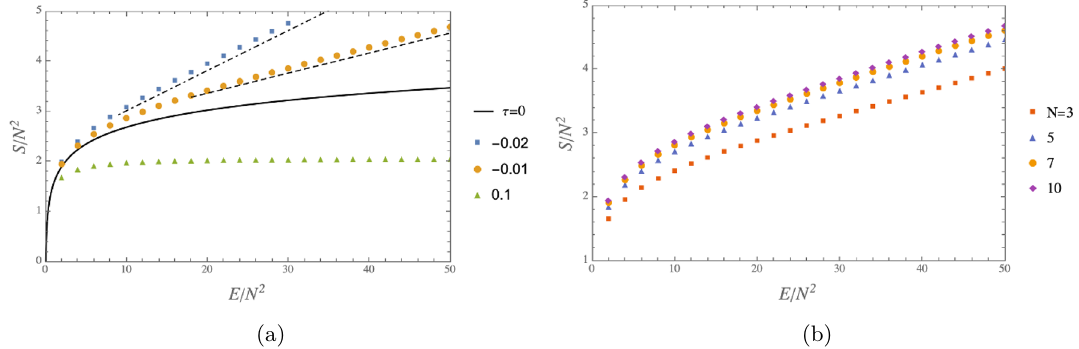
Figure 2. (a) Thermodynamic entropy for different values of τ at N = 10 . The slopes of the dashed and dash-dotted lines are − 4 τ (1 + τ/ 12) at τ = − 0 . 01 and τ = − 0 . 02 correspondingly. (b) The entropy at τ = − 0 . 01 for different values of N